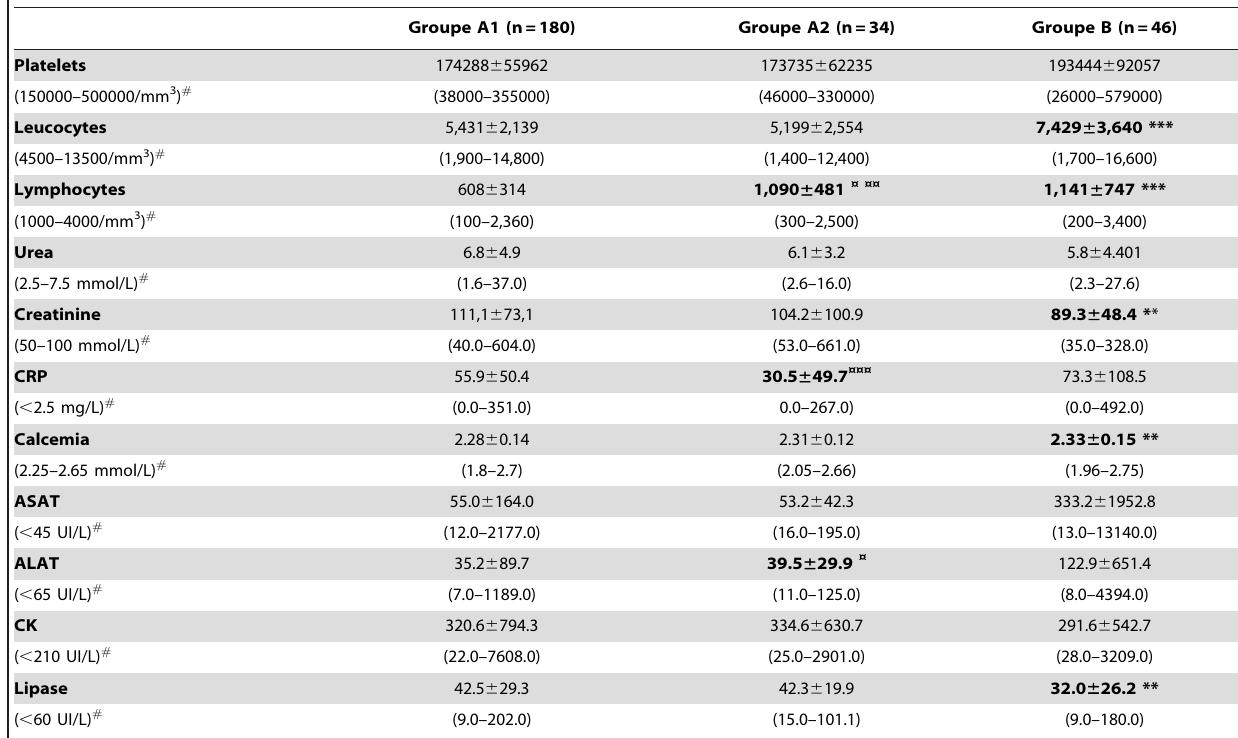
Table 6. Biological